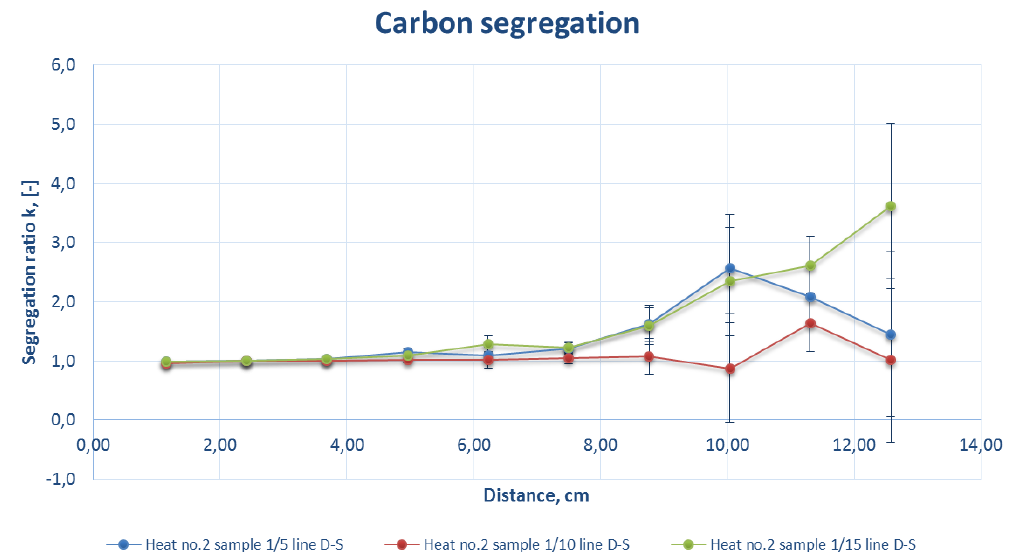
Figure 9. Comparison of the carbon segregation ratio for the sample DS line of strand 1 at a casting speed of 2.5 m/min (heat number 2).